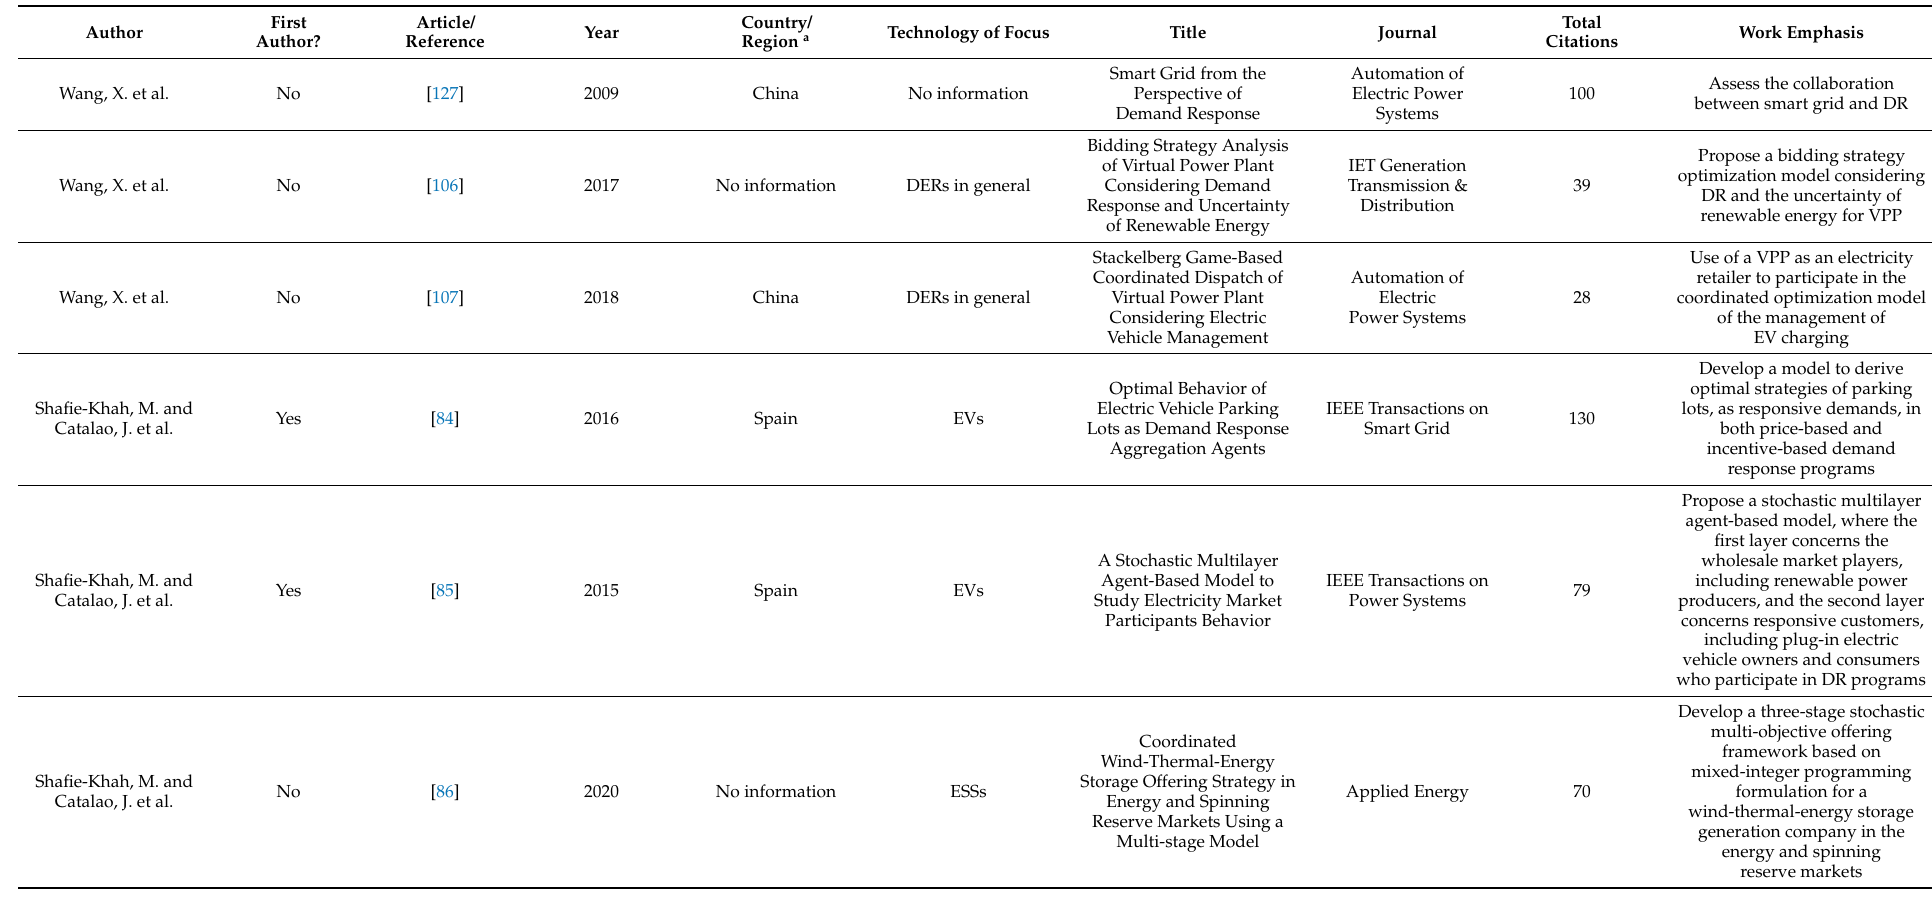
Table A1. Main authors’ most-cited articles from Sample 1. Source: own study using data from